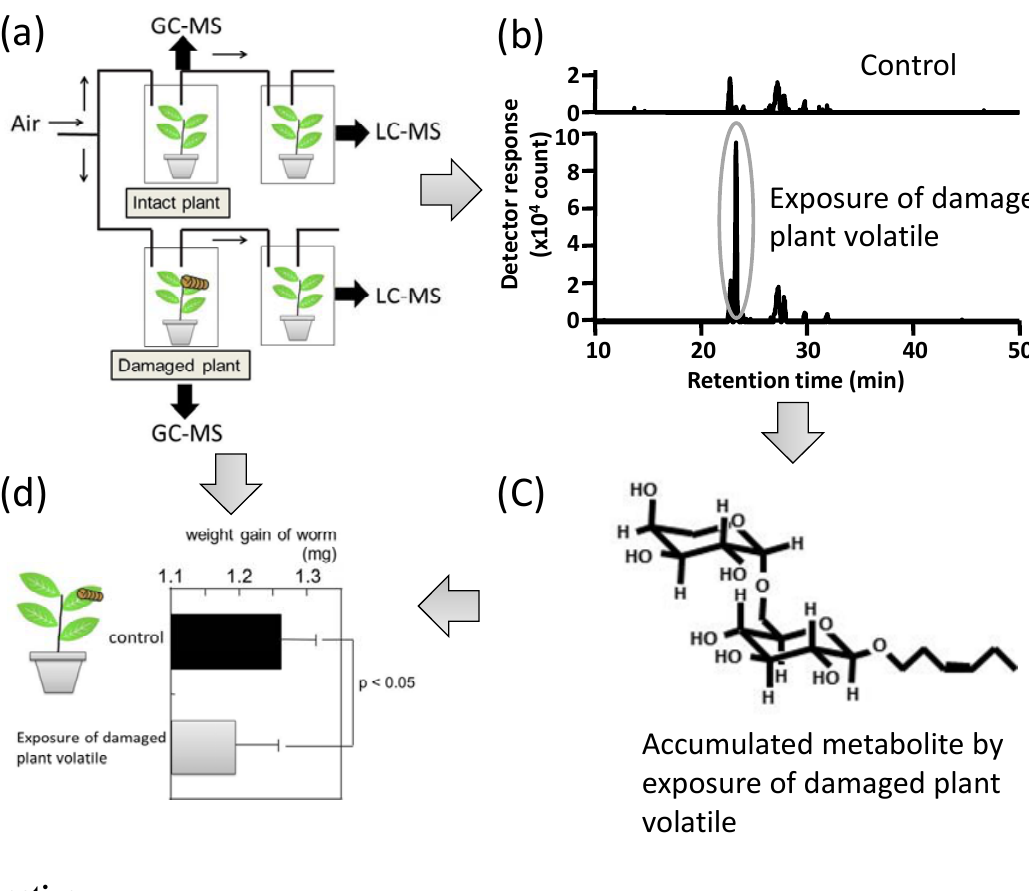
Figure 3. Multiplatform metabolic profiling identified the mechanism of plant-plant communication by green leaf volatiles. ( a ) Airflow setup for volatile exposure. Intact tomato ( S. lycopersicum ) plant and the plant damaged by cutworm ( S. litura )